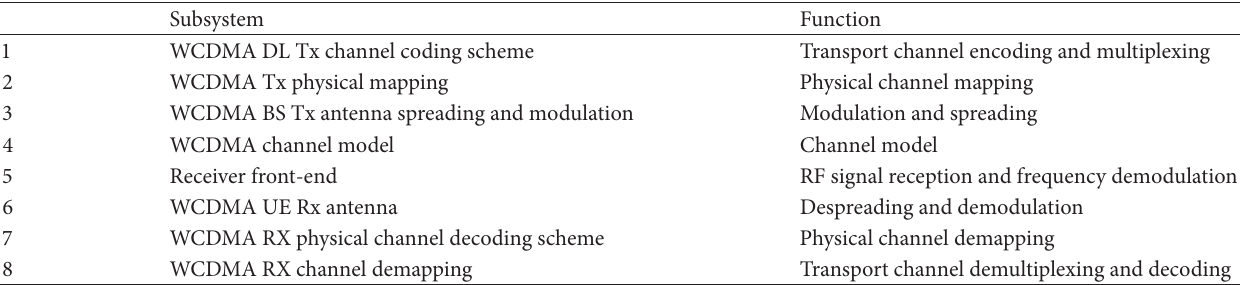
Table 1: WCDMA end-to-end physical layer